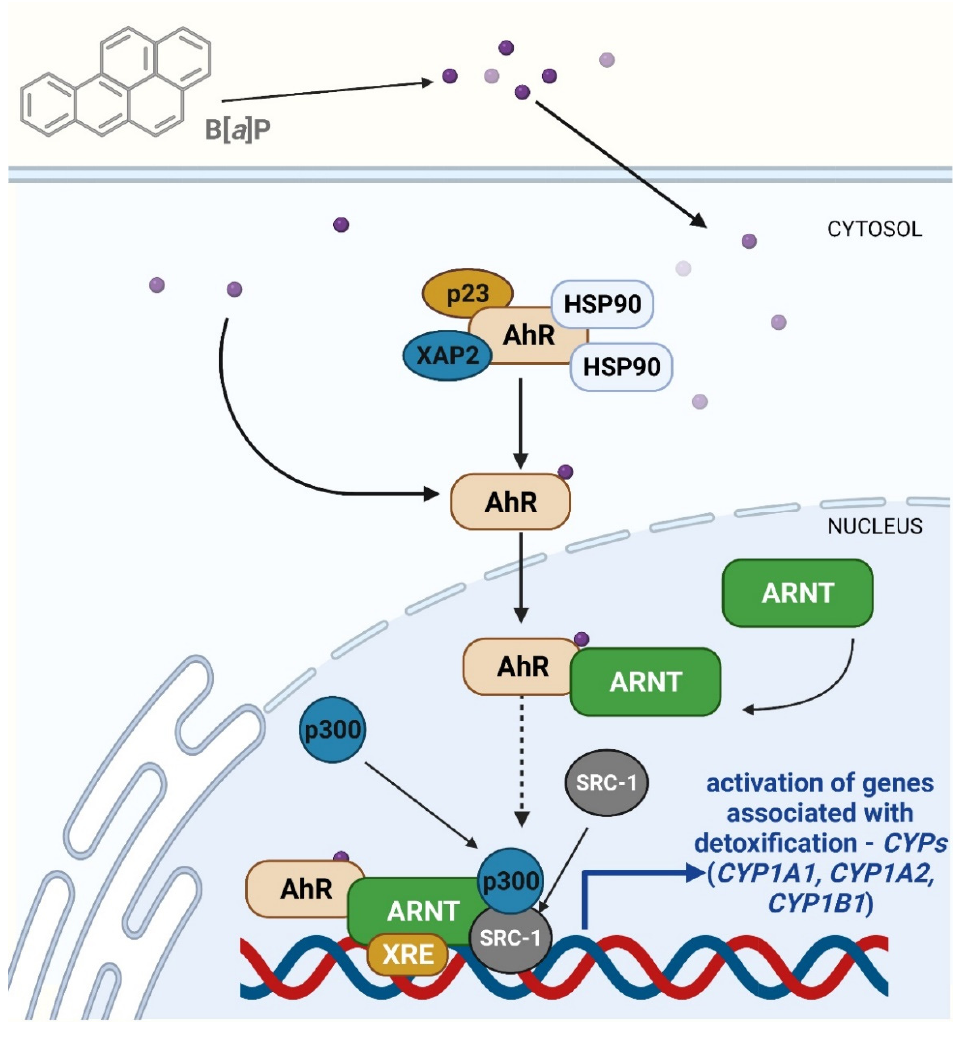
Figure 7. The aryl hydrocarbon receptor (AhR) is a ligand-activated transcription factor located in the cytosol. Inactive AhR occurs as a complex bonded with protein HSP90 (heat shock protein 90), p23 co-chaperone, and protein XAP2 (aryl hydrocarbon receptor-interacting protein, known also as AIP) or arachidonic acid (ARA). Binding AhR with ligand (B[ a ]P) leads to translocation of the active form of receptor to the nucleus and binds it with AhR receptor nuclear translocator (ARNT). Attachment of specific transcription factors (xenobiotic response element, XRE; histone acetyltransferase p300, steroid receptor coactivator-1, SRC-1) triggers gene machinery leading to activation of detoxification pathways (mainly by cytochrome P450 activation, CYPs). Intensification of ROS production can be correlated with DNA damage, mutation (mainly via PBDE), and carcinogenesis [122]. Created with BioRender.com (accessed on 12 April 2022).